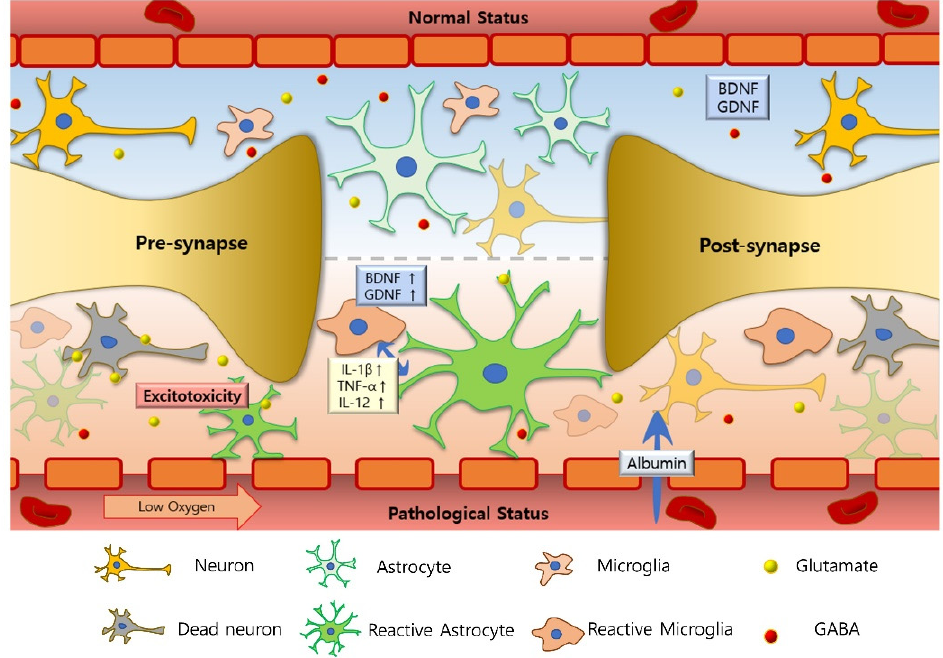
Figure 1. Changes associated with neuron-glia interactions in neurodevelopmental disorders. Inflammatory cytokines such as IL-12, IL-1 β , and TNF- α are increased in neurodevelopmental disorders compared to normal individuals [13–15]. The increased cytokines activate astrocytes and microglia; these glial cells expand as a result of gliosis and release glutamate into the extracellular space, which kills the neurons. However, in patients with epilepsy, the blood-brain barrier opens, leading to the increased entry of albumin ( ↑ ) into the brain and astrocyte activation [16]. Unusually, in epilepsy, the released cytokines are known to facilitate functional neurogenesis and induce the release of neurotrophic factors such as neuronal growth factor (NGF), brain-derived neurotrophic factor (BDNF), and glial-cell derived neurotrophic factor (GDNF) ( ↑ ) [17–20].